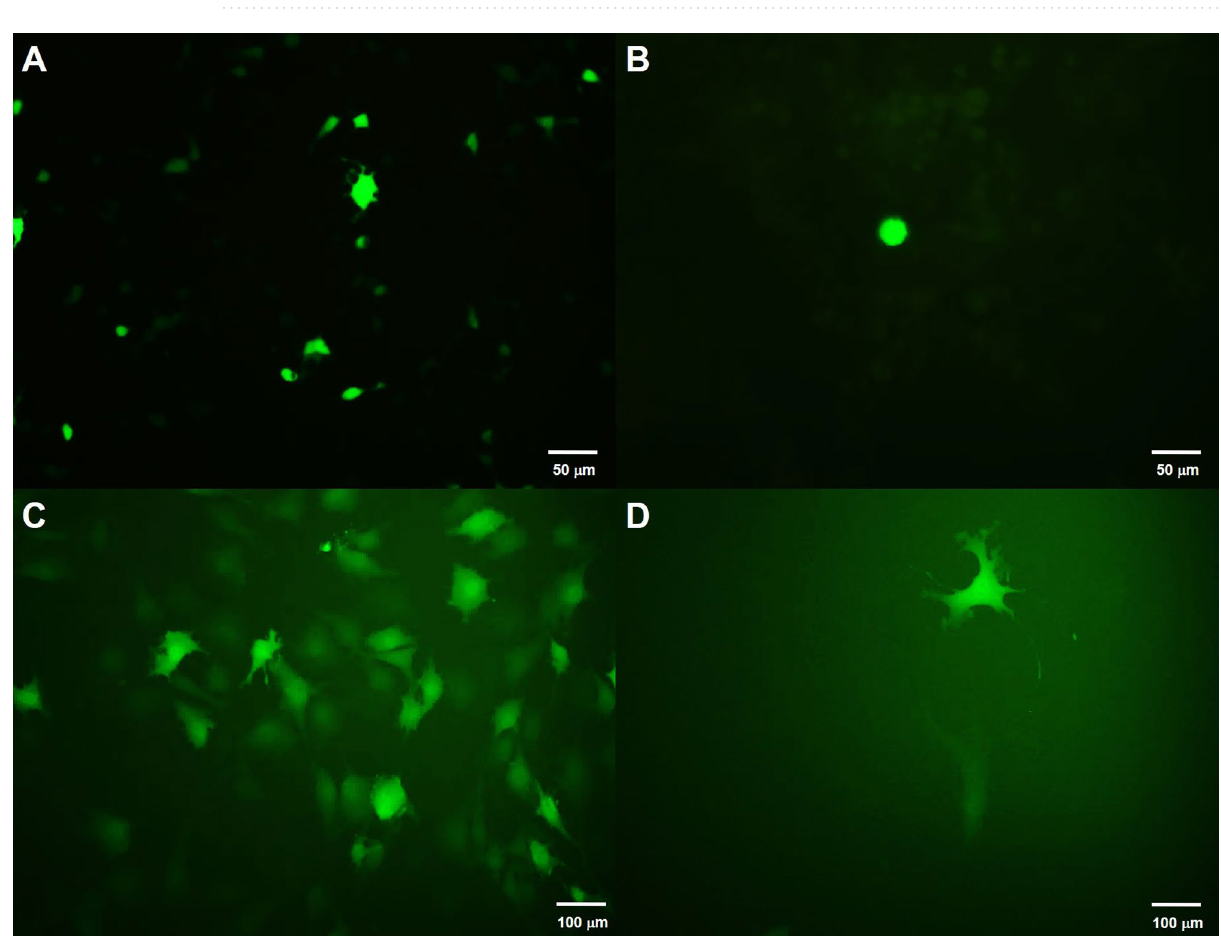
Figure 3. Lentiviral transduction CCs. ( A ) Successful transfection was observed in HEK293T cells using Lipofectamine 3000 after 24 h. ( B ) GFP-transduced CCs using lentivirus concentrated by Lenti-X™ Concentrator, ( C ) GFP-transduced CCs using lentivirus concentrated by ultracentrifugation, and ( D ) GFP- transduced CCs after passaging for one